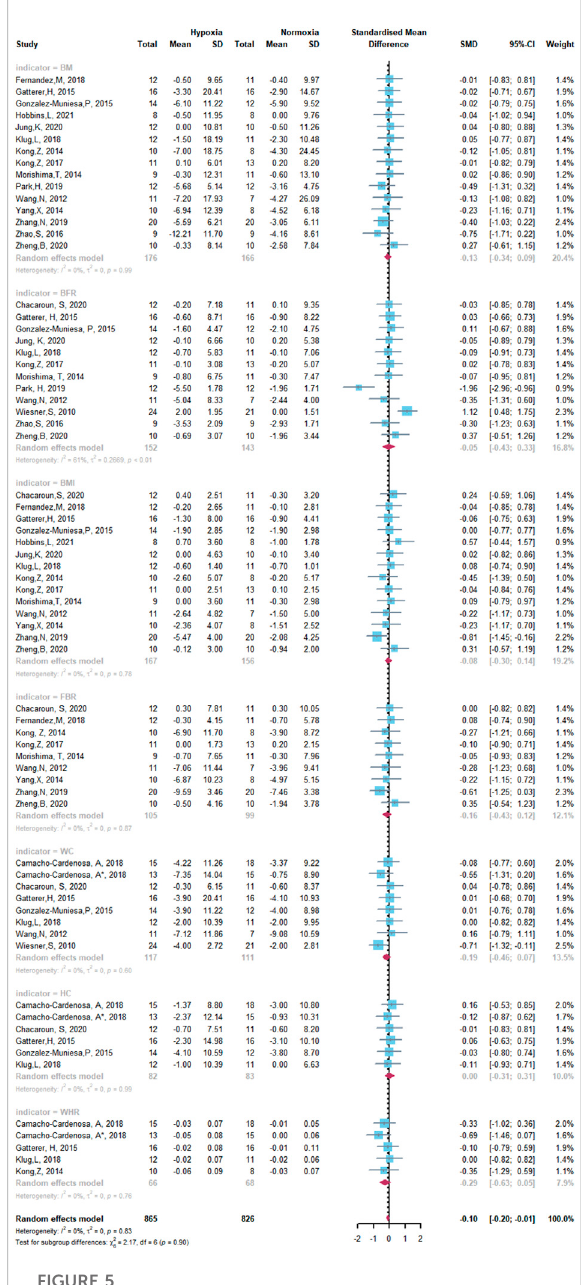
FIGURE 5 Forest Plot of the Meta-analysis on body